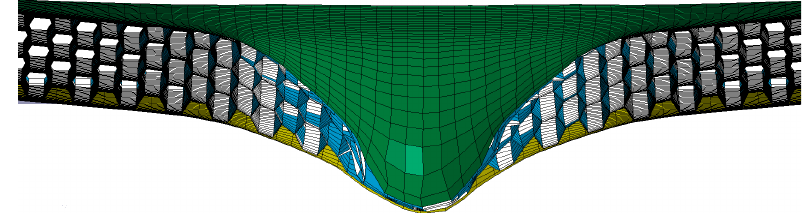
Figure 5. Rebound stage of the honeycomb sandwich structure with a Poisson’s ratio of 1.